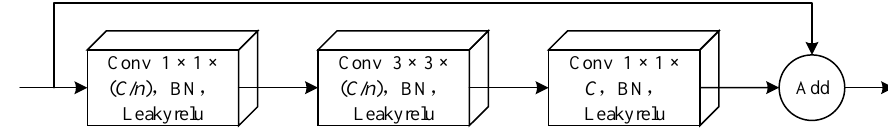
Figure 4. Residual structure.